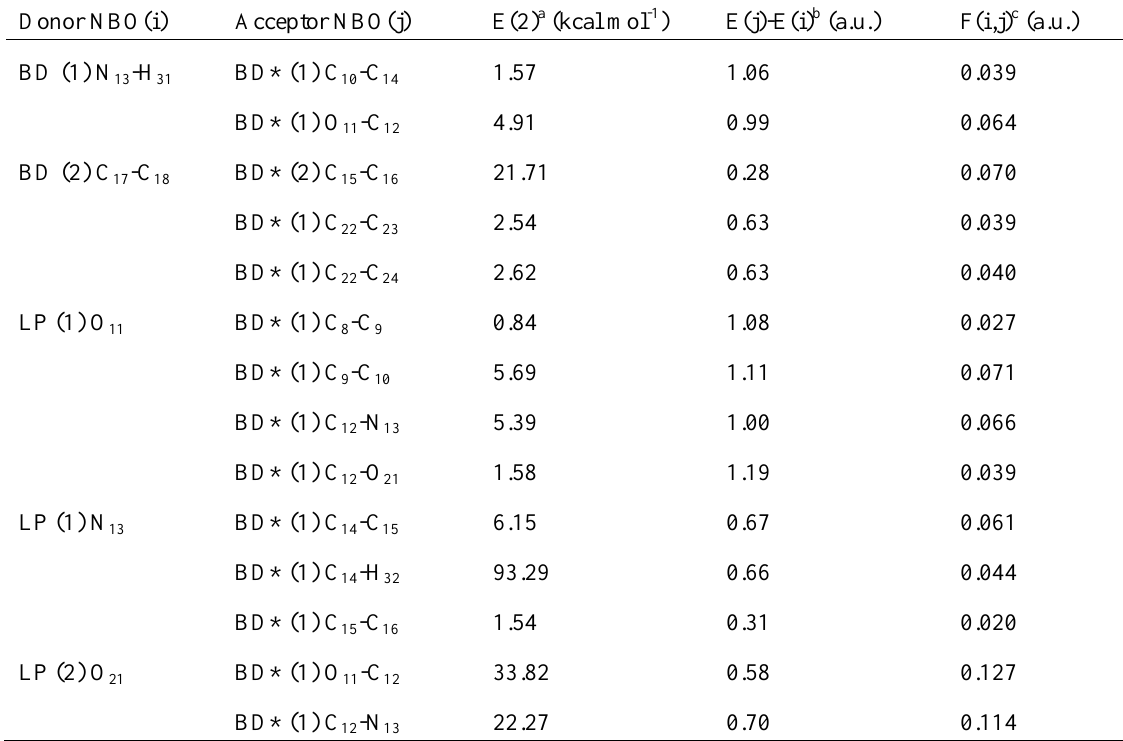
Table 9. Significant Donor-Acceptor Interactions and Second Order Perturbation Energies of 4i Compound Calculated at B3LYP/6-311+G* Level (Atom Labeling Corresponds to Fig.